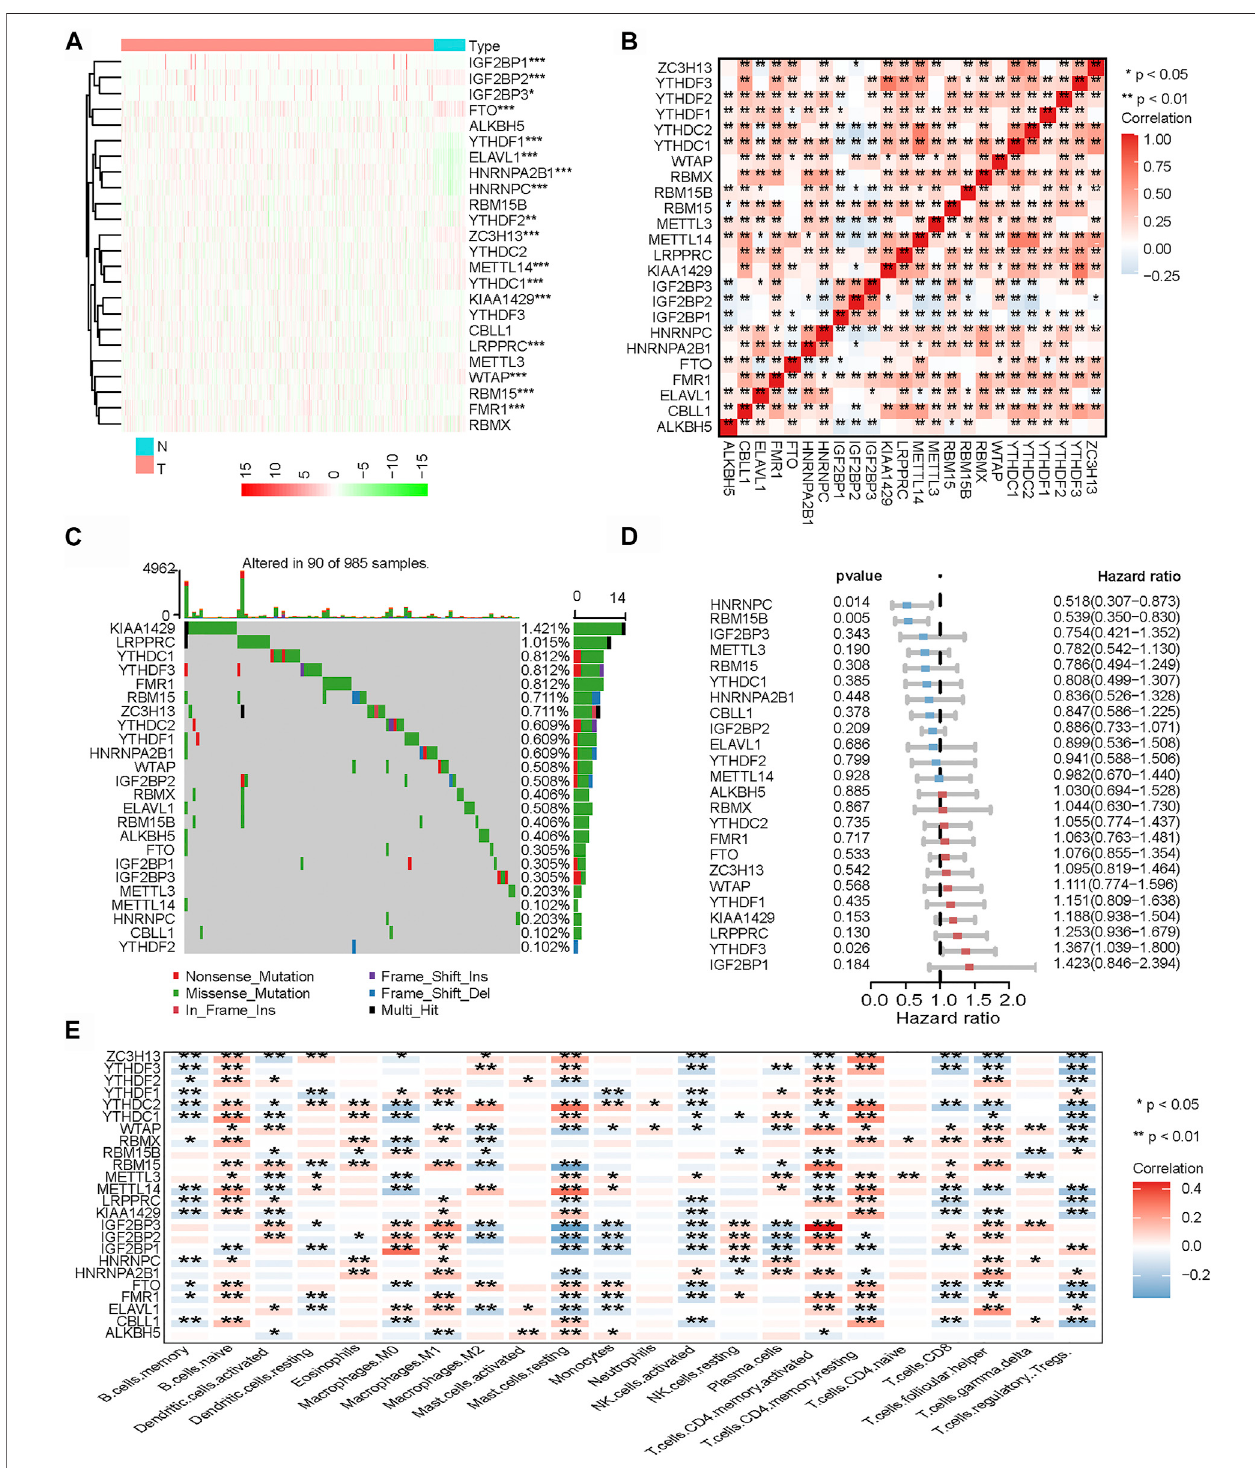
FIGURE 2 | Landscape of N 6 -methyladenosine (m6A) regulators in breast cancer. (A) Heatmap of all m6A regulators in breast cancer tissues and normal tissues from The Genome Cancer Atlas (TCGA) database. Each column represents individual patients ( blue indicates normal tissue, pink indicates breast cancer tissue; the darker the red , the more obvious the upregulation of gene expression, and the darker the green , the more obvious the downregulation of gene expression). (B) Co- expression of m6A regulators (* p < 0.05; ** p < 0.01; *** p < 0.001). (C) Mutation frequency of 24 m6A regulators in 985 breast cancer samples from TCGA-BRCA cohort. (D) UnivariateCoxregressionwasperformedtoanalyzethehazardratioofeachm6A-relatedgeneinpredictingoverallsurvivalinbreastcancer. (E) CIBERSORT was used to analyze the component correlation between the 22 immune cells [tumor microenvironment (TME) in fi ltrating cells] and 24 m6A regulators (* p < 0.05; ** p < 0.01; *** p < 0.001).